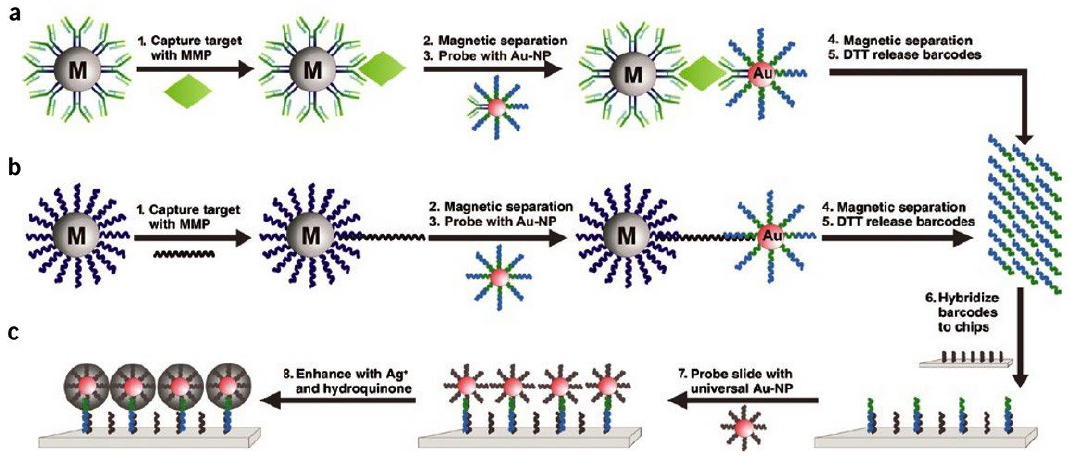
Figure 4. Assay using bio-barcodes for the detection of DNA and proteins. A representation in schematic form of ( a ) the identification of proteins by the use of the bio-barcode test; ( b ) detection of nucleic acids by the use of the bio-barcode test; as well as ( c ) the econometric detection method. Reproduced with permission from [24]. Copyright Elsevier, 2014.